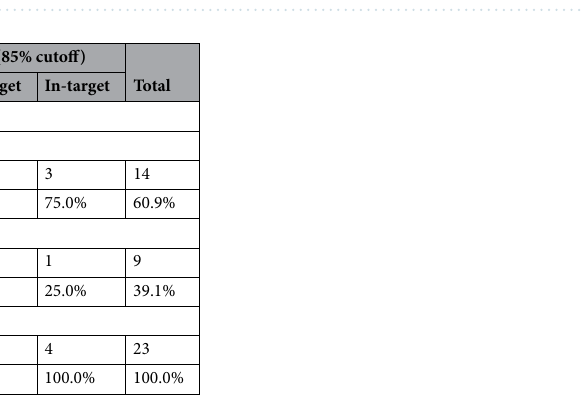
Figure 2. The faculties in general’ Readiness–KPIs for capacity and infection transmission rate. The blue columns represent the overall faculties Readiness–Capacity KPIS level, which ranges from 80 to 85%. The infection transmission rate on each level is represented by the orange